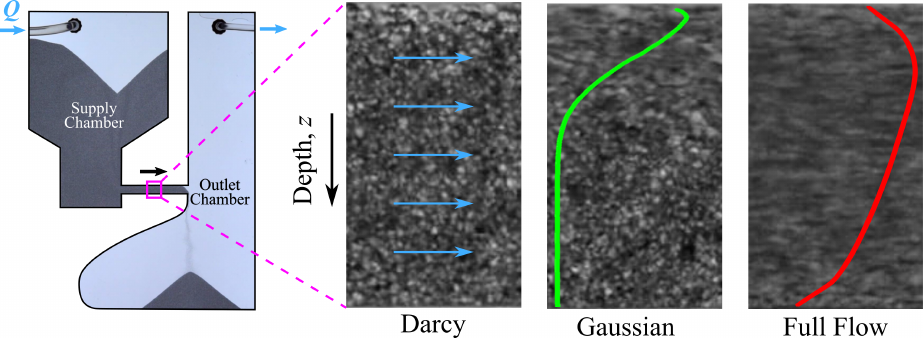
Figure 1. The flow cell (left) and images of grain flow in the channel for each of the three flow regimes (right). The blue arrows represent the flow of interstitial fluid through the pore space of the static packing and the green and red lines show the grain velocity profiles of the Gaussian (0.5 ml / min) and full flow (15 ml / min) regimes respectively in a 3 mm channel.